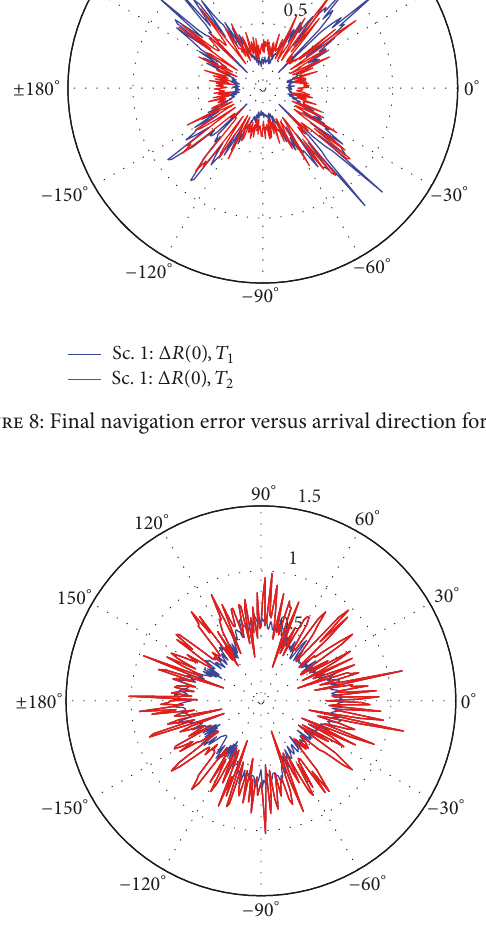
errors. This fact results from the comparison of mean errors, which are 7.10 m, 2.66 m, and 3.10 m, respectively, for 𝛼 = {0 ∘ , 20 ∘ , 40 ∘ } . However, the navigation error that occurs at the destina- tion landing point is most significant. Hence, the influence assessment of the approach direction in the azimuth plane on the final error of the VTOL positioning is made on the basis of simulation research. For Sc. 1 and Sc. 2, the obtained results are presented in Figures 8 and 9,